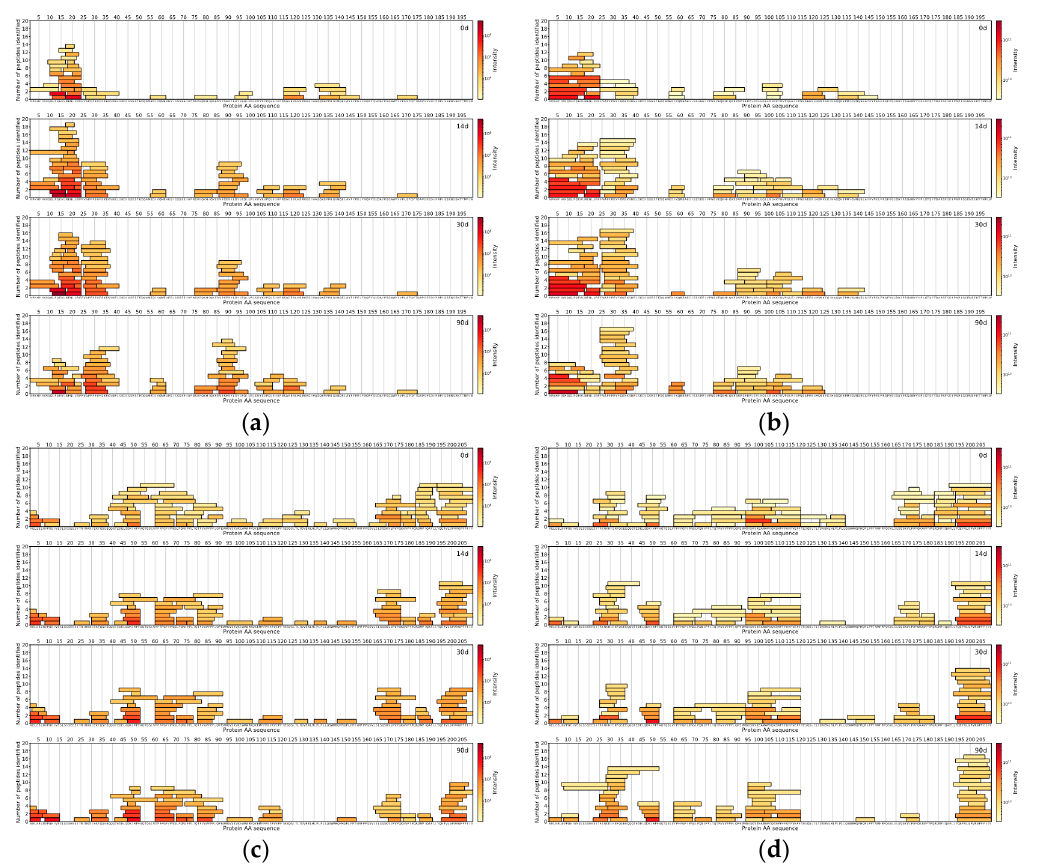
Figure 6. Cheese 3 α s1 -CN: ( a ) DIA-MS and ( b ) DDA-MS. Cheese 3 β -CN: ( c ) DIA-MS and ( d ) DDA-MS. The X -axis represents the casein amino acid sequence, the Y -axis represents a number of peptides and colour represents the logarithmically scaled intensity of peptides.